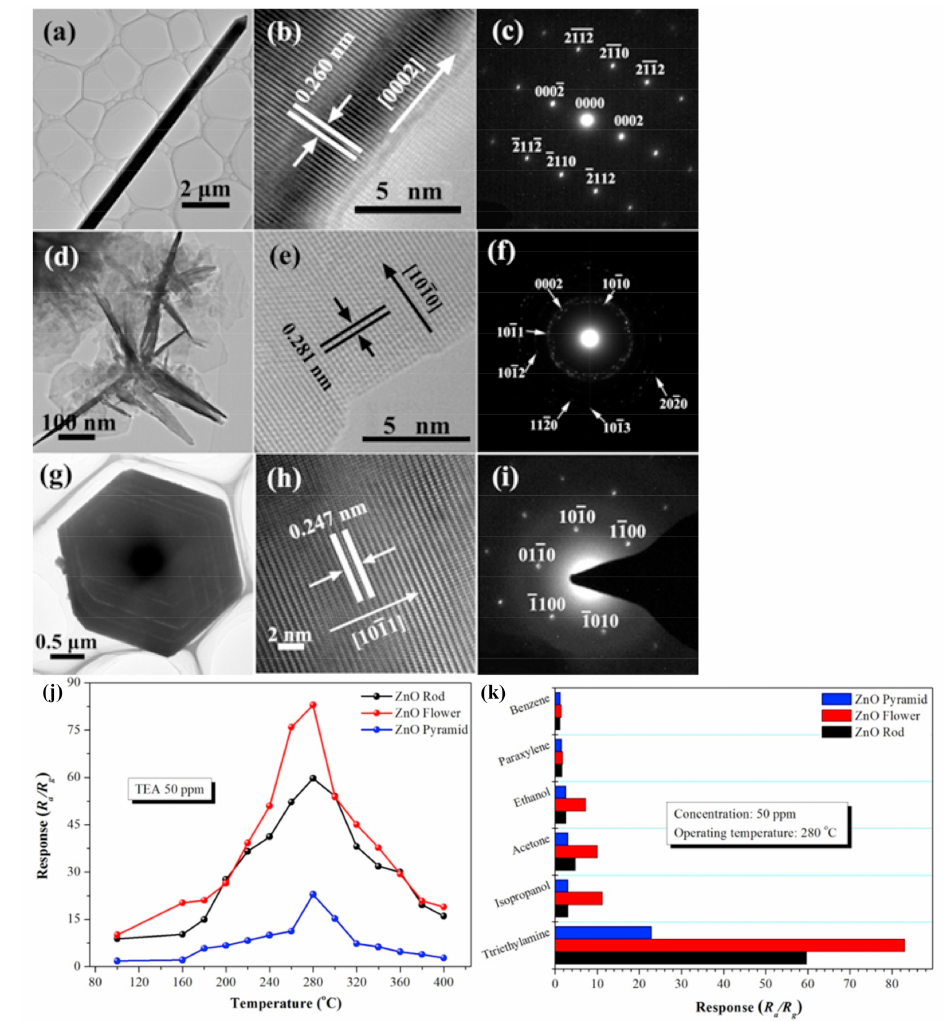
Figure 7. ( a – c ) TEM image, corresponding HRTEM image and SAED pattern of ZnO rod; ( d – f ) TEM image, corresponding HRTEM image and SAED pattern of ZnO flower; ( g – i ) TEM image, correspond- ing HRTEM image and SAED pattern of ZnO pyramid; ( j ) Gas sensitivity of ZnO versus working temperature towards 50 ppm of triethylamine; (k) Selectivity comparison of ZnO sensors under 50 ppm of various target gases at 280 ◦ C, Reprinted from Ref. [138] with permission of Elsevier Ltd.,